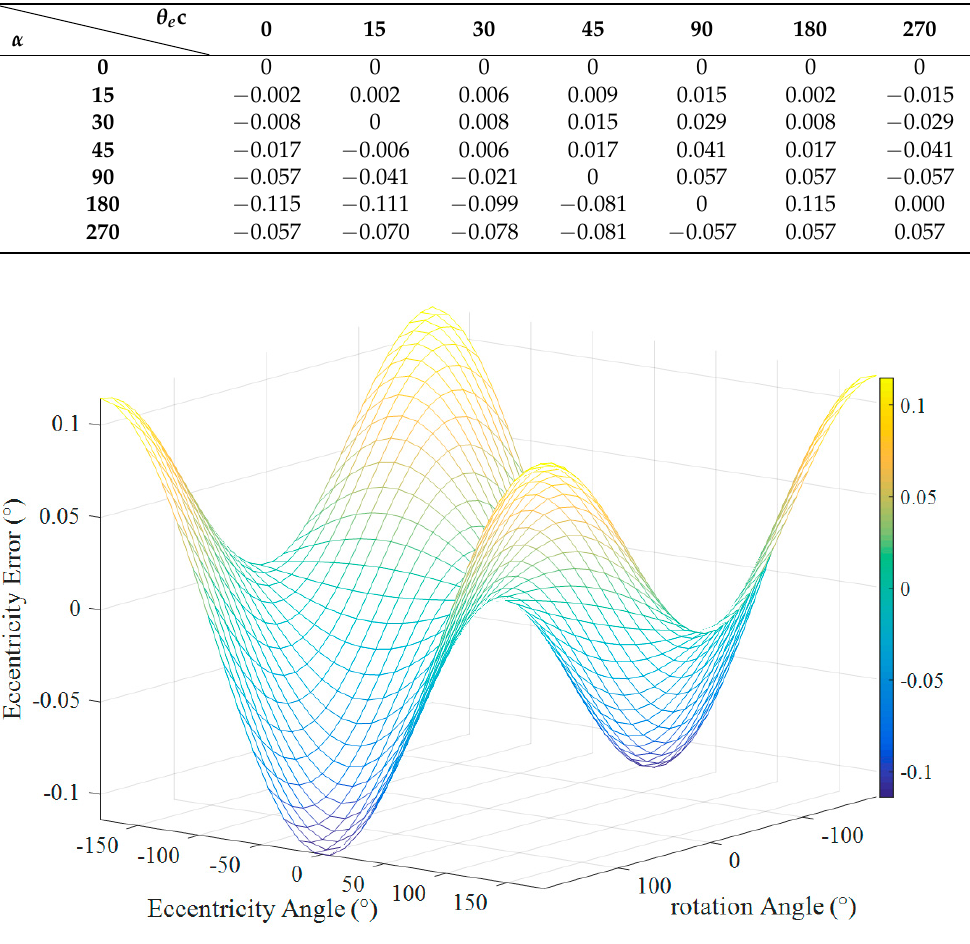
Figure 4. The eccentricity error δ e varied with the eccentric angle θ e (when e = 0.1 mm). Let r = 100 mm, L = 35.5 mm, θ = 0.1 ◦ , and θ L = θ e + 30 ◦ . The shafting rotated one turn, and the value of α was from 0 ◦ to 360 ◦ . The angle measurement error data calculated by using the proposed inclination error model (Equation (14)) are shown in Table 3. Table 3. Simulation data of the inclination error (unit: